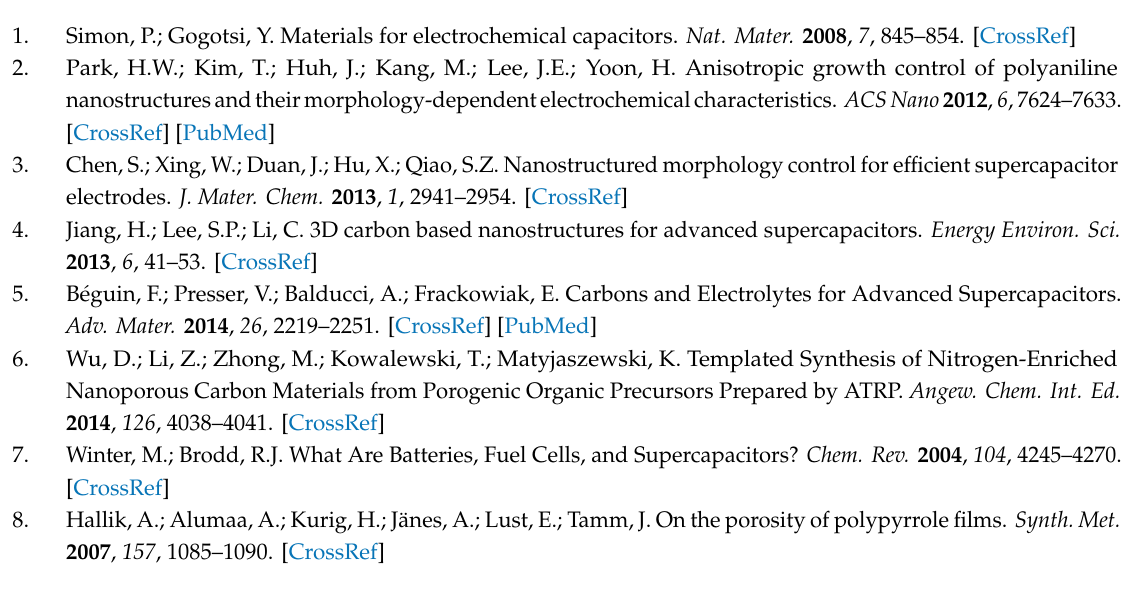
Figure S1: AFM image of PANI–DBSA., Table S1: FTIR band position of PANI–DBSA along with their